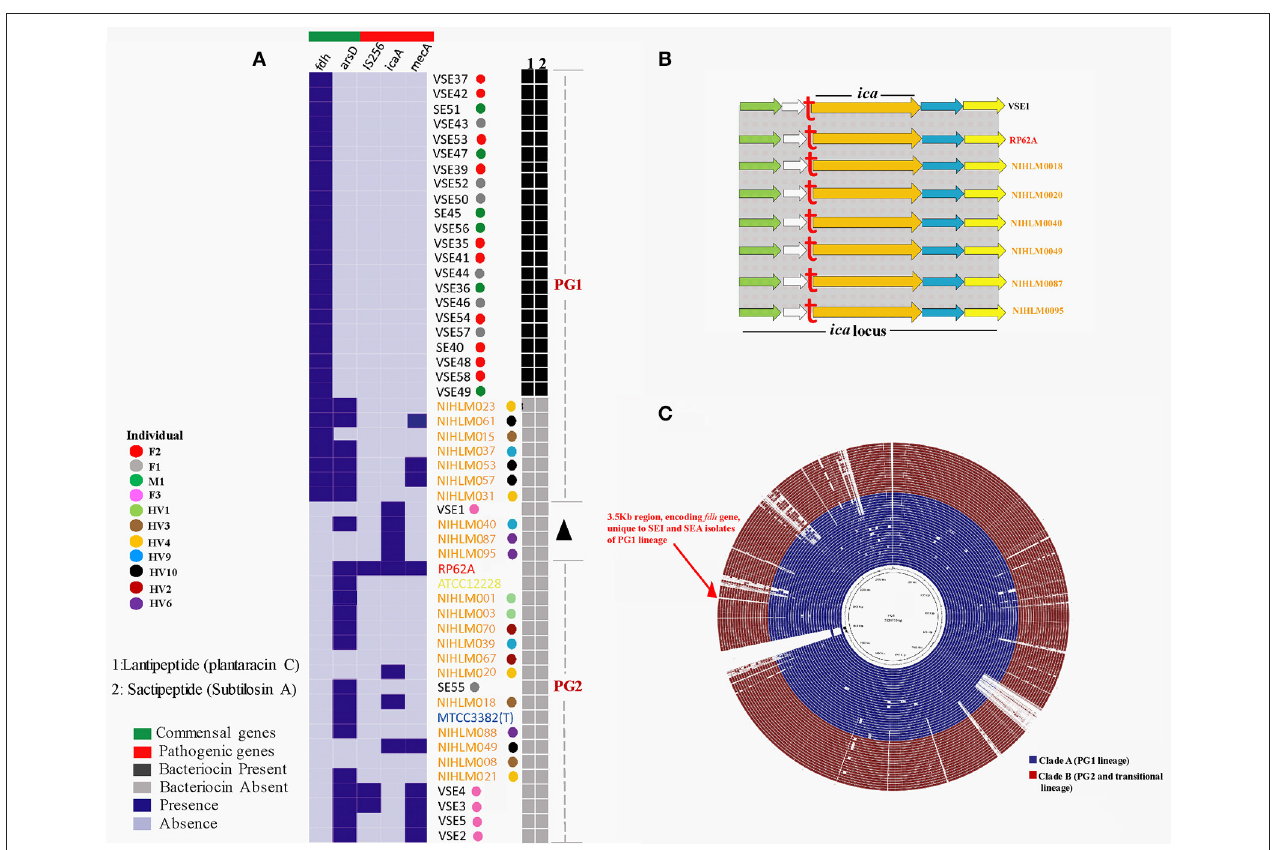
FIGURE 3 | (A) In-silico mining of potential commensal and pathogenic markers in isolates and type strain. Blue color indicates presence of the corresponding gene, which is estimated as 100% coverage of the gene with identity value > 80% and Light blue color indicates absence of the gene, which is estimated by no identity, e -value > 0 or coverage < 5. Different color-coding is representation for different individuals. Details of the individuals are provided in metadata in Table S2. Bacteriocins, lantipeptide and sactipeptide are denoted by 1 and 2 respectively. Their presence or absence is marked by Dark gray and Light gray respectively. (B) Complete ica cluster along with upstream downstream regions in icaA positive isolates. A red “t” indicates presence of tRNA in all isolates. The whole cluster along with downstream, upstream genes is exactly similar in all isolates. Green: MFS transporter, Blank: Hypothetical gene, Blue: Lipase, Yellow: N-acetyltransferase. (C) Blast based comparative analysis of 49 S. epidermidis isolates by BRIG, taking VSE35 as reference, blue color represents PGI isolates and red color represents PG2 and transitional lineages isolates, irrespective of geographic